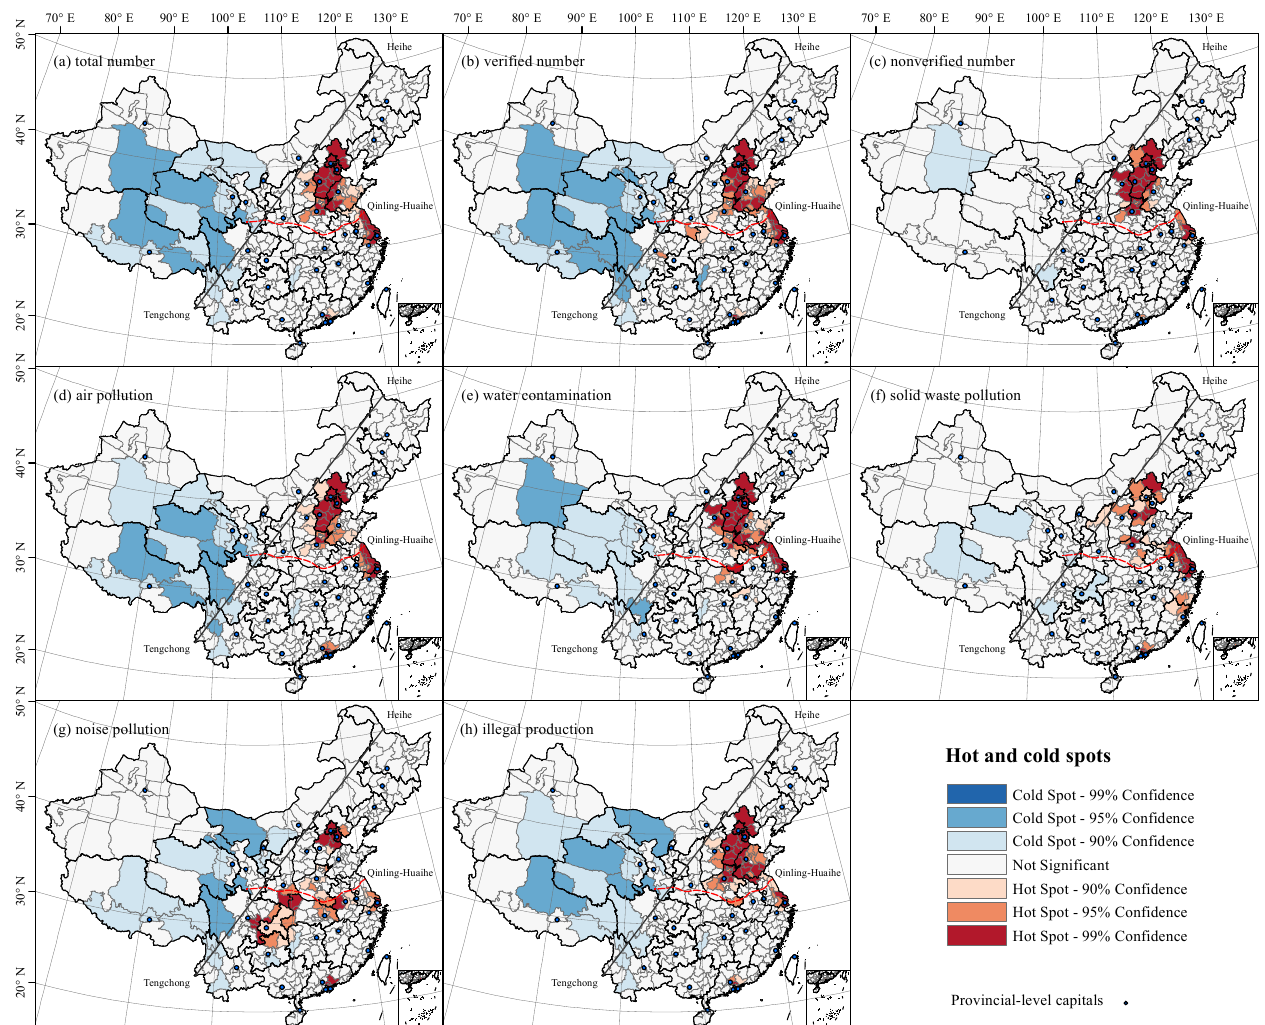
Figure 3. Spatial clusters of hot and cold spots of environmental complaints in China.